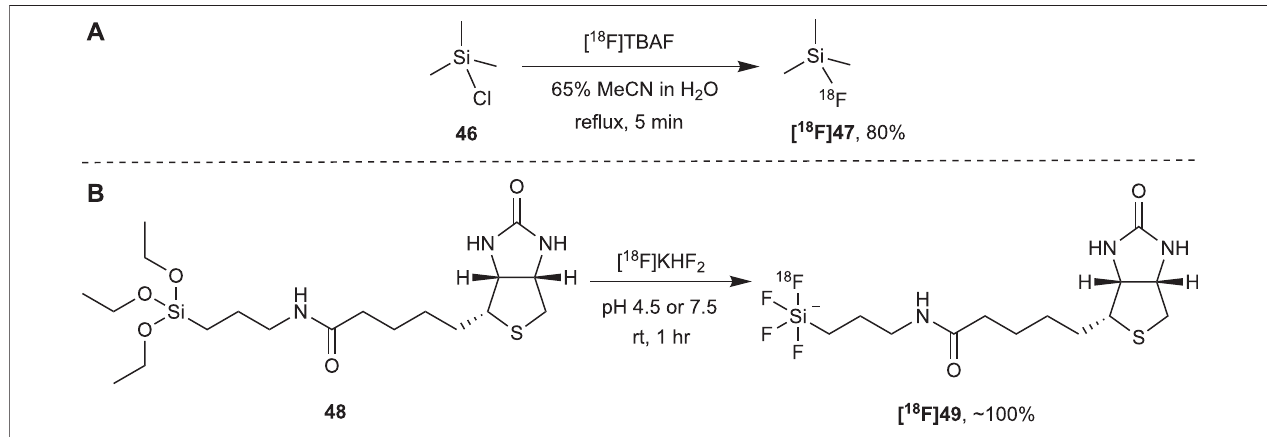
FIGURE6|(A) The fi rstreporteddirectnucleophilicradiolabelingofamoleculewith[ 18 F] fl uorideatsiliconunderaqueousconditionsinvolvedthe fl uorinationofsilyl chloride 46 with [ 18 F]TBAF. (B) The biotin derivative 48 can be directly radiolabeled with [ 18 F] fl uoride at room temperature over a broad pH range and within an hour in almost quantitative yields. Carrier